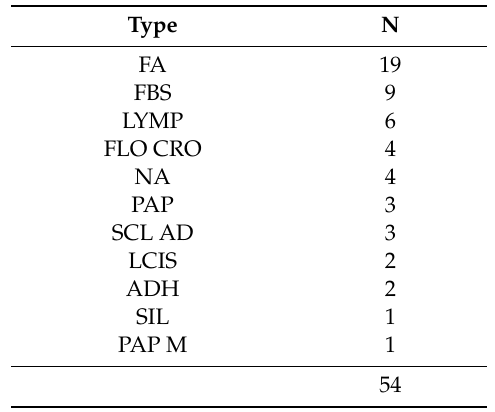
Table 1. Benign lesions detected by histopathology.